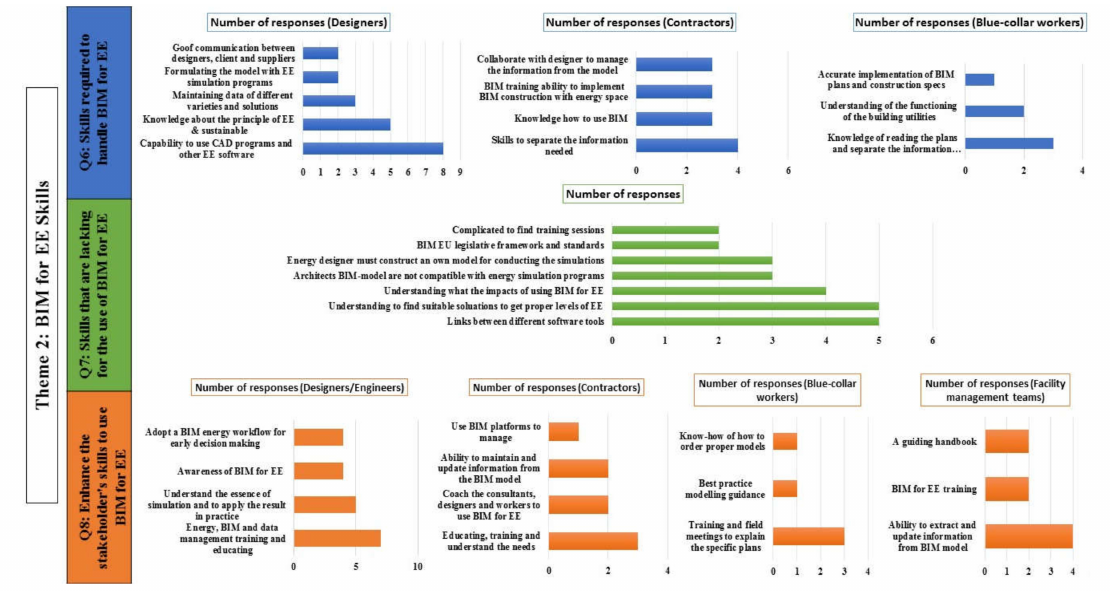
Figure 11. The number of responses for BIM for EE